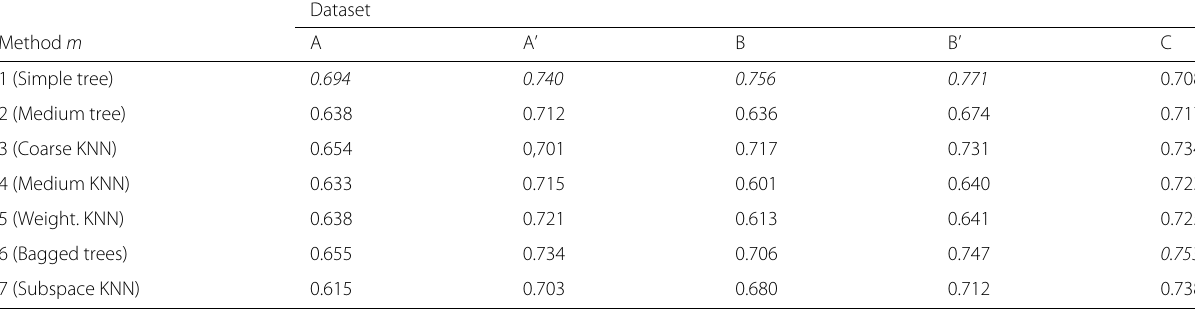
Table 2 Comparison of attention prediction accuracies of tested machine learning methods Dataset